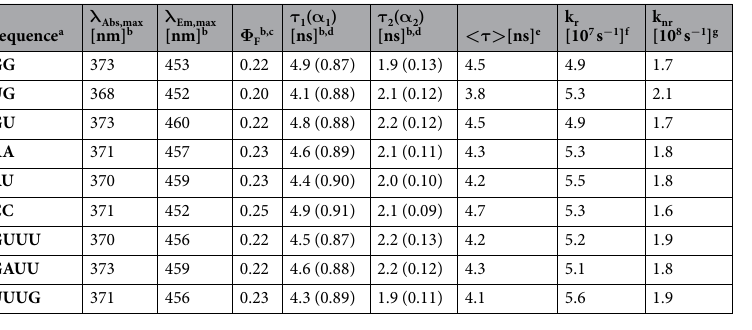
Table 3. Optical properties of tC O -containing RNA double strands. a Sequences are named after the bases flanking tC O (see Fig. 1b). Full sequences can be found in Supplementary Table S1. b Measurements were performed in PBS buffer (100 mM Na + , pH 7.5). c Fluorescence quantum yields are measured relative to the quantum yield of the potassium salt of the tC O -monomer in water ( Φ F = 0.30) 31 . d The amplitudes are indicated in parenthesis. e Mean fluorescence lifetimes < τ > = ∑α i τ i / ∑α i . f Radiative rate constant, k r = Φ F / <τ> . g Non- radiative rate constant, k nr = k r / Φ F − k r